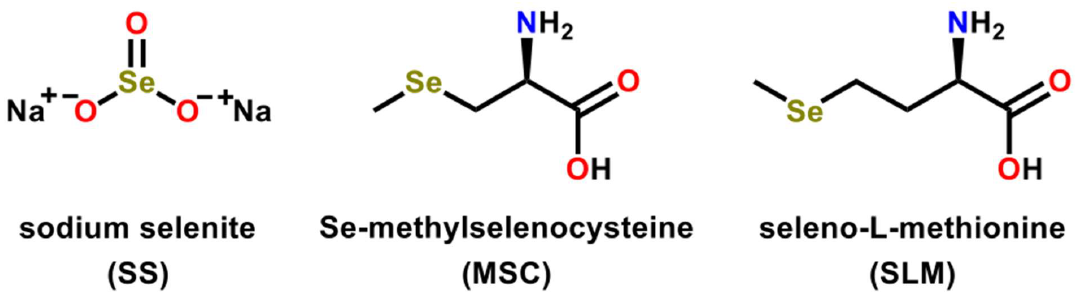
Figure 2. Chemical structures of sodium selenite (SS), methylselenocysteine (MSC), and seleno-L- methionine (SLM), which are well studied selenocompounds that have demonstrated anti-cancer properties.